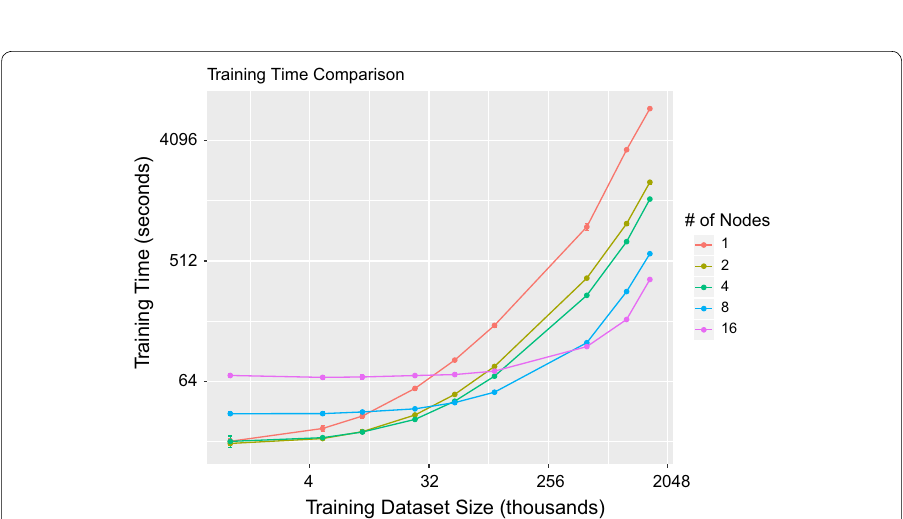
Fig. 3 Visualization of training time with respect to training data size in thousands. Each line represents results from a cluster with N number of nodes. Note that the X and Y scale are logarithmic, and clearly shows the constant overhead of the larger clusters on small